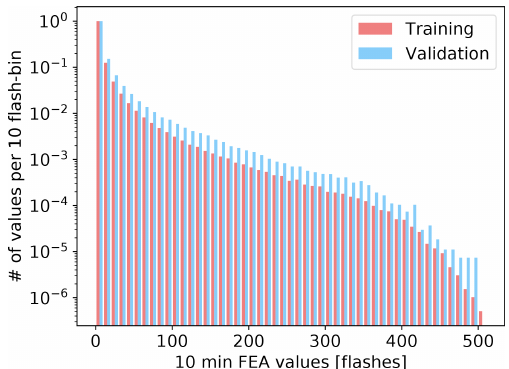
Figure 4. Histograms of all 10min FEA values greater than 0 for each 7km by 7km pixel for the training dataset and the val- idation dataset, both normalized to their maximum binned value, i.e. 1955622 for the training and 270310 for the